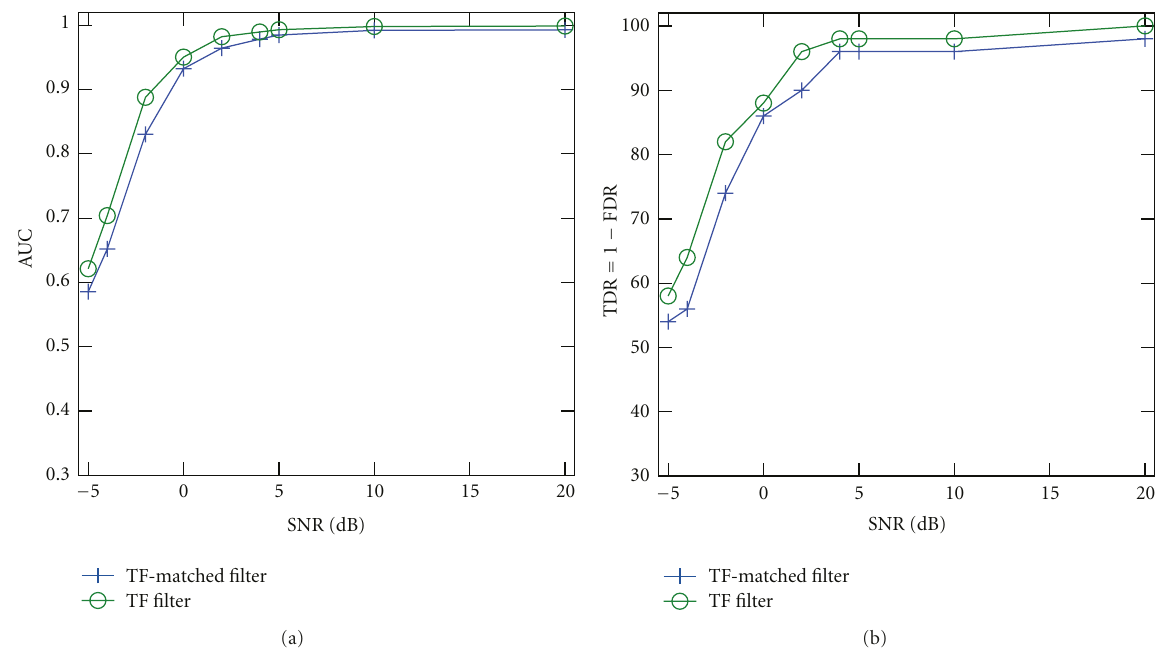
Figure 14: Detection results for coloured Gaussian noise with low-energy